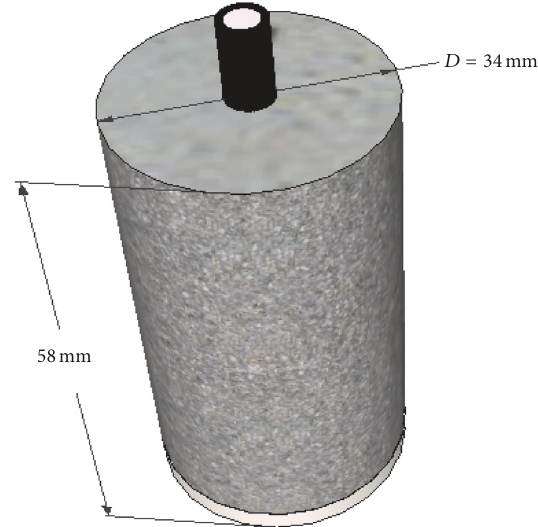
Figure2:Specimengeometryfortheacceleratedcorrosiontestused in